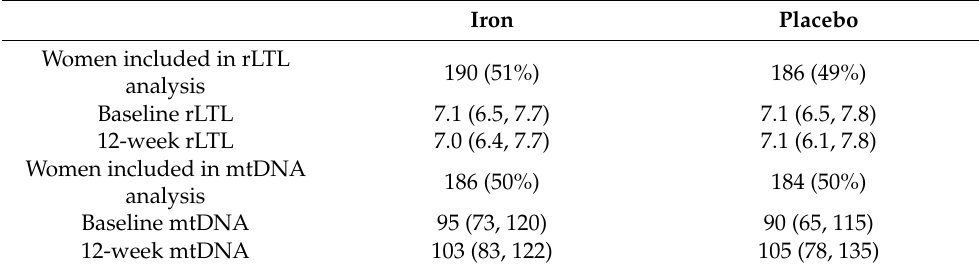
Table 2. Unadjusted baseline and 12-week rLTL and mtDNA content by supplement group 1,2 .